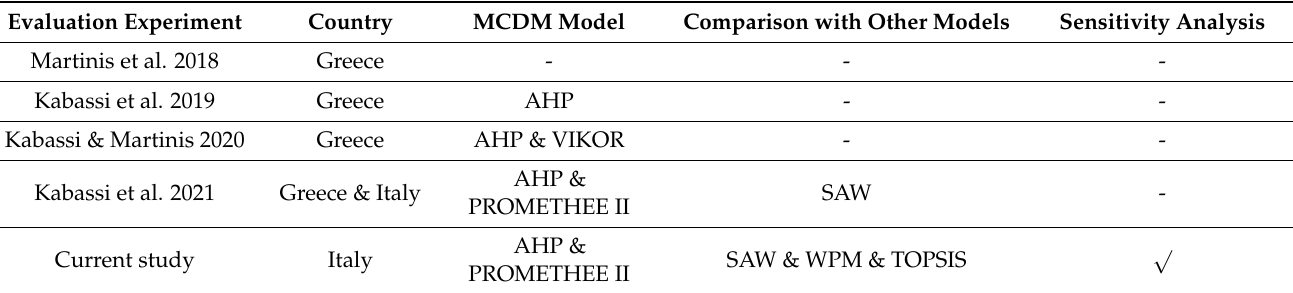
Table 6. Evaluation experiments of the websites of national